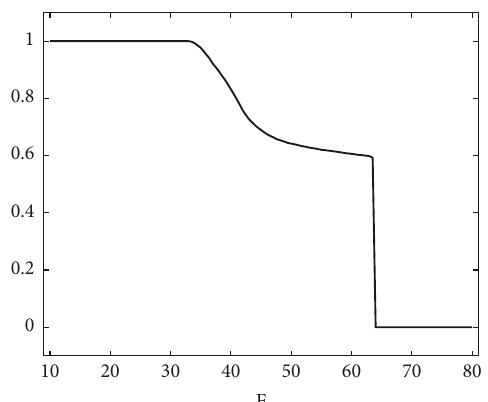
, 𝑦 ) which do not converge 0 0